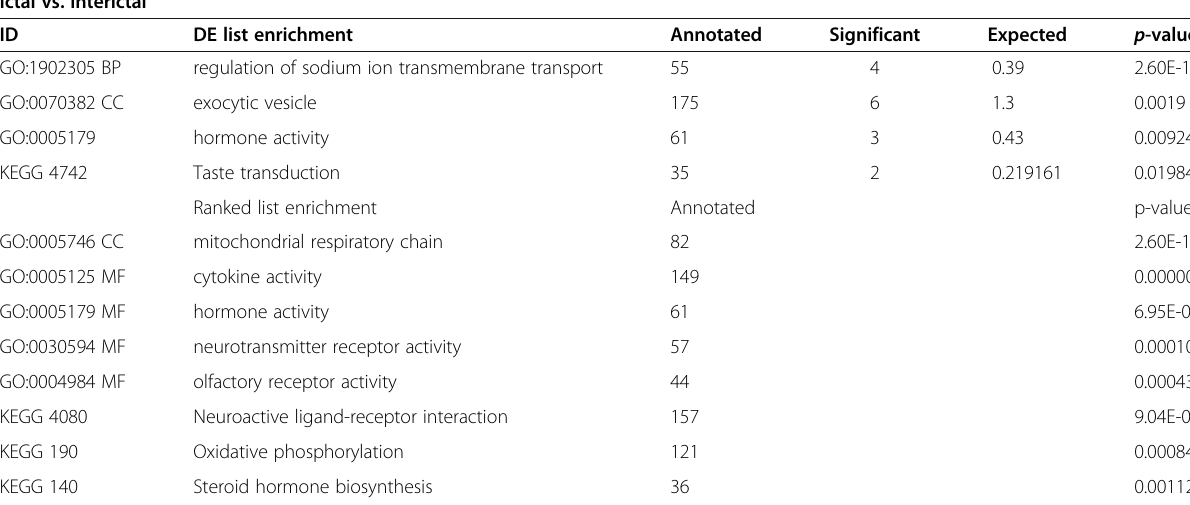
Table 3 Functional enrichment results of PBMC RNA-seq data of the ictal vs. interictal comparison. DE list enrichment: overrepresentation of functional terms in the differentially expressed gene list. Ranked list enrichment: enrichment of genes associated with a certain pathway towards the top of the ranked whole data. GO: gene ontology, BP: biological process, CC: cellular component, MF molecular function. KEGG: Kyoto Encyclopedia of Genes and Genomes. Annotated: number of genes associated with the given term. R: Reactome database. Significant: number of statistically significant associated with the given term. Expected: expected number of genes associated with the given term in the DE gene list. Gene ratio: ratio of number of genes in the DE list that overlap with genes associated with the given term, and the number of genes in the DE list which overlap with genes associated with all terms in the Reactome database. Bg ratio: ratio of the number of genes associated with the given term, and the total number of genes associated with Reactome